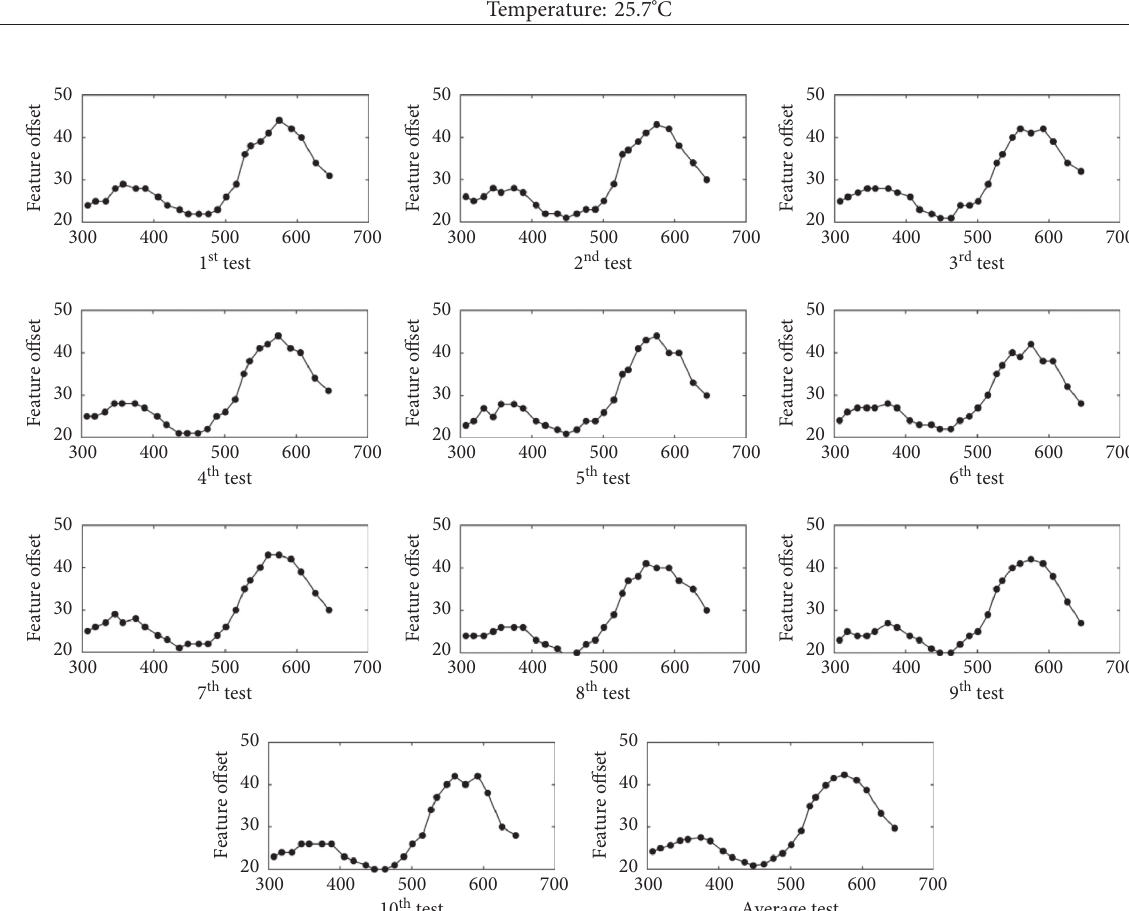
Figure 6: Relationship between FO and AFP’s sampling sequence